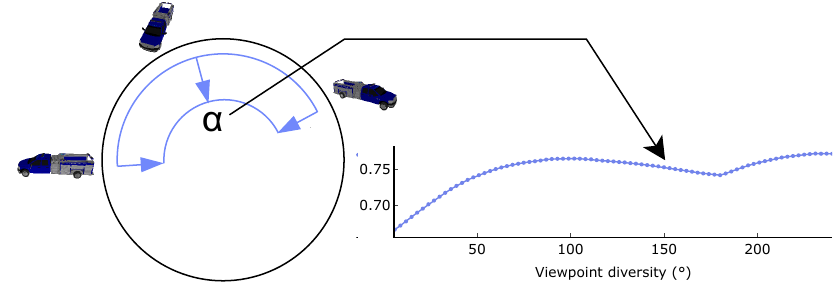
Figure A1. IoU obtained plotted over the angle between the furthest reaching viewpoints.